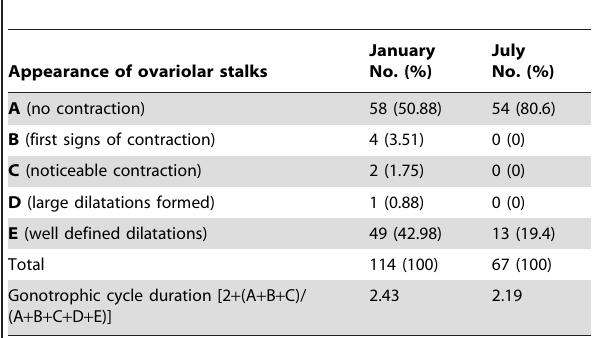
Table 2. Appearance of ovariolar stalks of An. darlingi after oviposition determined in January and July 2004.